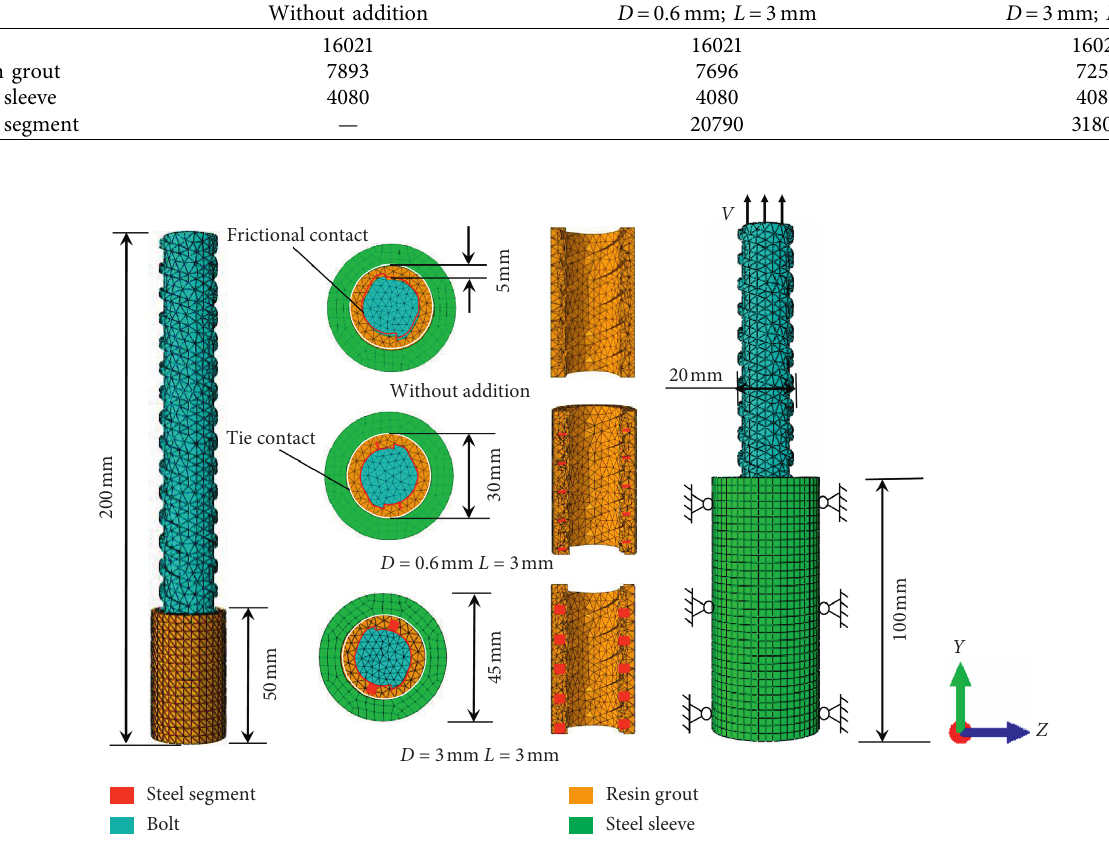
Figure 6: Numerical calculation model.